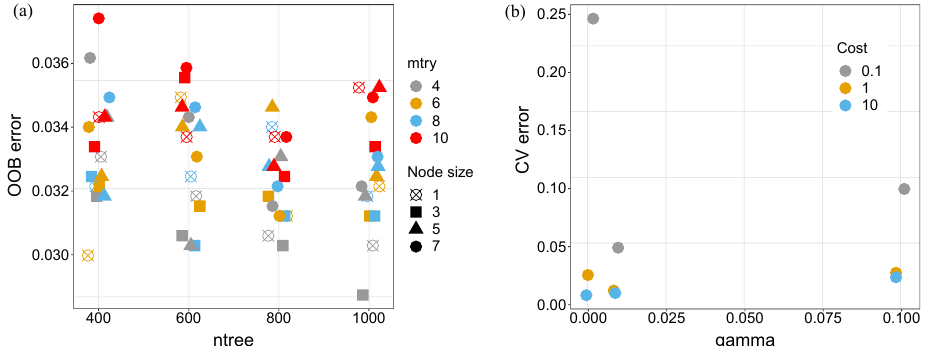
Figure 8. Result of the calibration process for the two-class classification task. ( a ) RF model. ( b ) SVM model.